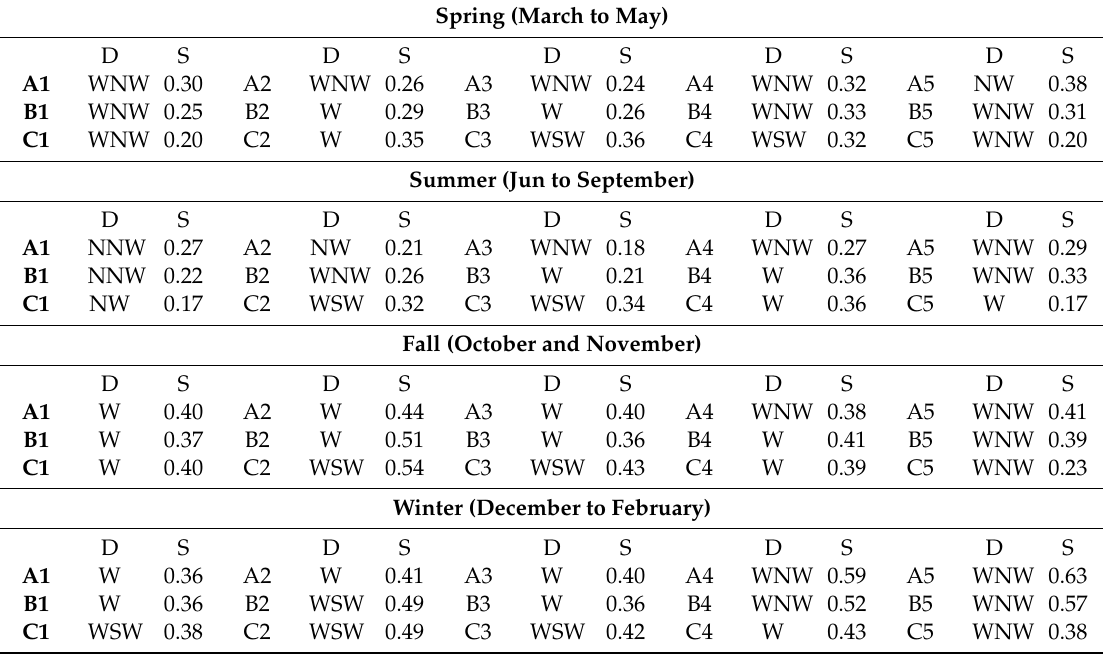
Table A4. Flow data during the flood period from the CODAR data (Figure 10). S represents the flow speed (m / s) and D represents the flow direction (sixteen